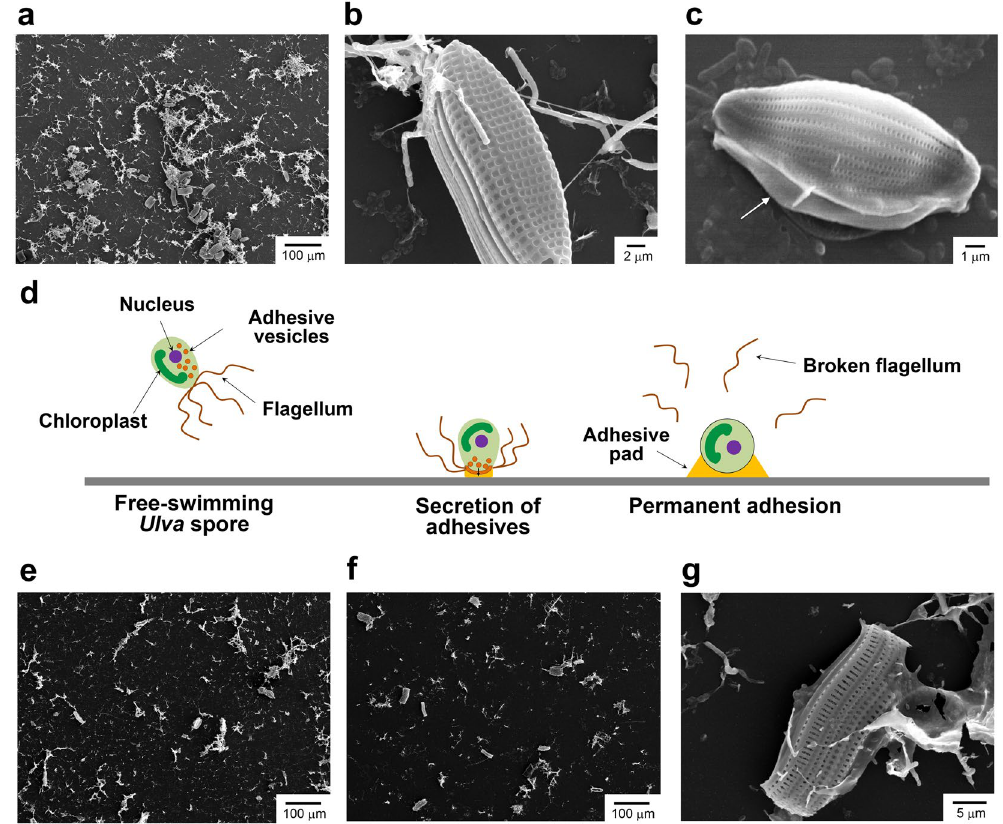
Figure 4. ( a – c ) SEM images of the surface of glass exposed to Ulva spore suspension in natural seawater without biocides under the summer condition for 24 h. ( d ) Schematic description of settlement process of Ulva spores. SEM images of the surface of glass exposed to Ulva spore suspension in natural seawater containing CuPT at concentrations of 10 ppb ( e ) and 100 ppb ( f and g ) under the summer condition for 24